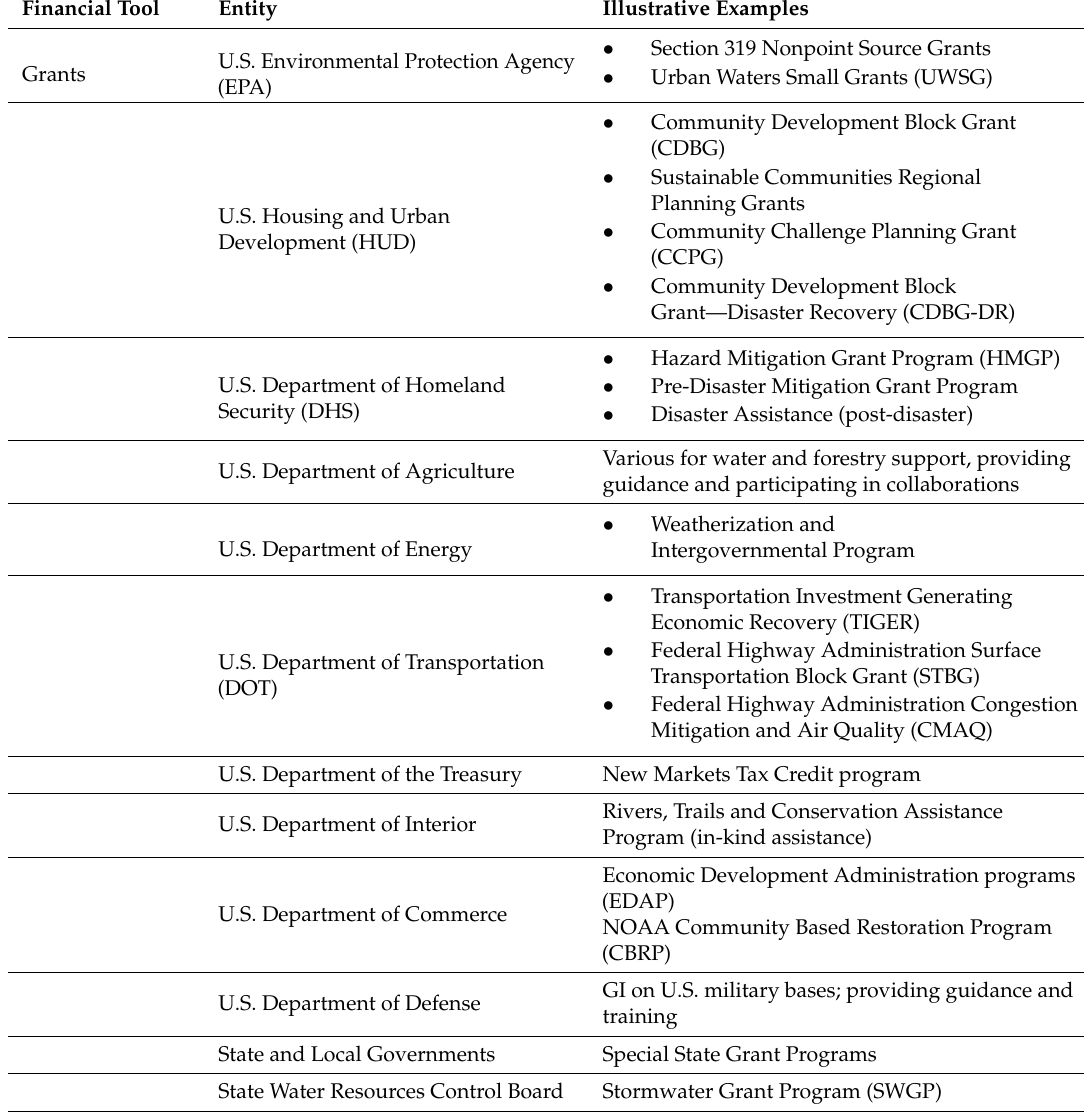
Table A1. Examples and summary of financial tools GIF financial tools summary. All information is drawn from